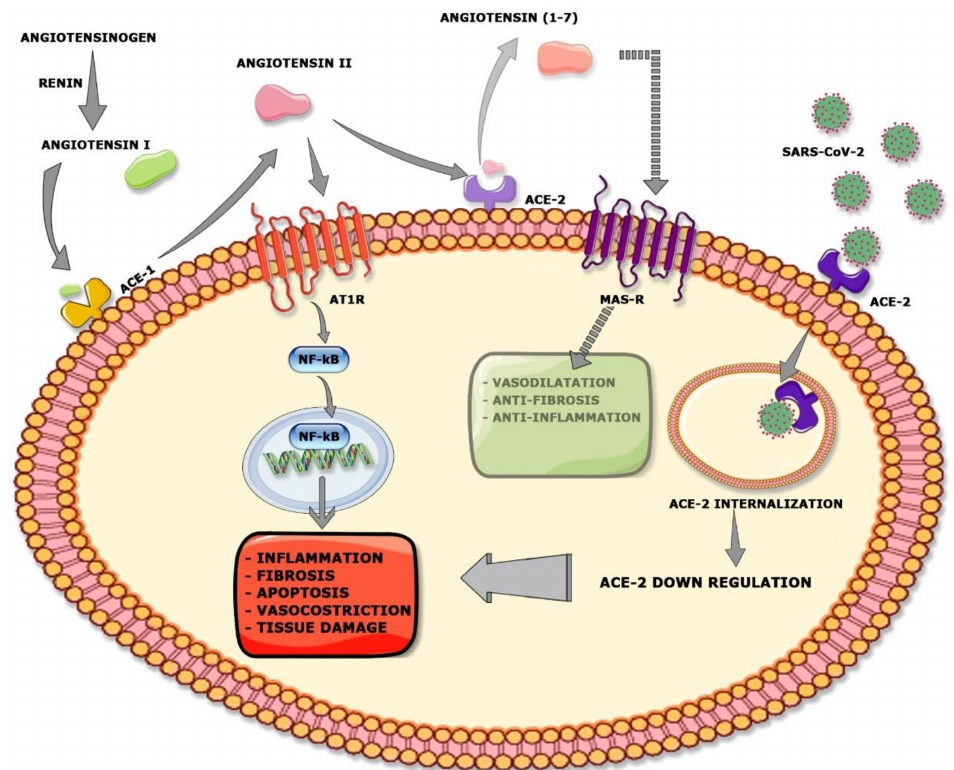
Figure 1. Viral entry mechanism of SARS-CoV-2 and RAS impairment. Angiotensinogen is cleaved into angiotensin I by renin, and then into angiotensin II by ACE-1. Then, Angiotensin II binds angiotensin receptor type I (AT1R) and modulates the gene expression of several inflammatory cytokines via NF- κ B signaling, inducingdeleteriouse ff ects(i.e., inflammation, fibrosis, apoptosis, vasoconstriction, andtissue damage). In normal conditions with a balanced RAS, both ACE-1 and ACE-2 are activated. Therefore, ACE-2 counteracts AT1R activation, inducing the cleavage of angiotensin II into angiotensin 1–7. Angiotensin 1–7 interact with the MAS receptor (MAS-R), promoting vasodilatation, and anti-fibrotic and anti-inflammatory processes. SARS-CoV-2 enters the host cell by binding with the ACE-2 receptor. The virus endocytosis causes a decrease of ACE-2 expression on the surface membrane that results in a down-regulation of the MAS-R pathway (faded image). Moreover, the accumulation of Angiotensin II induces an overactivation of AT1R signaling, increasing the cell